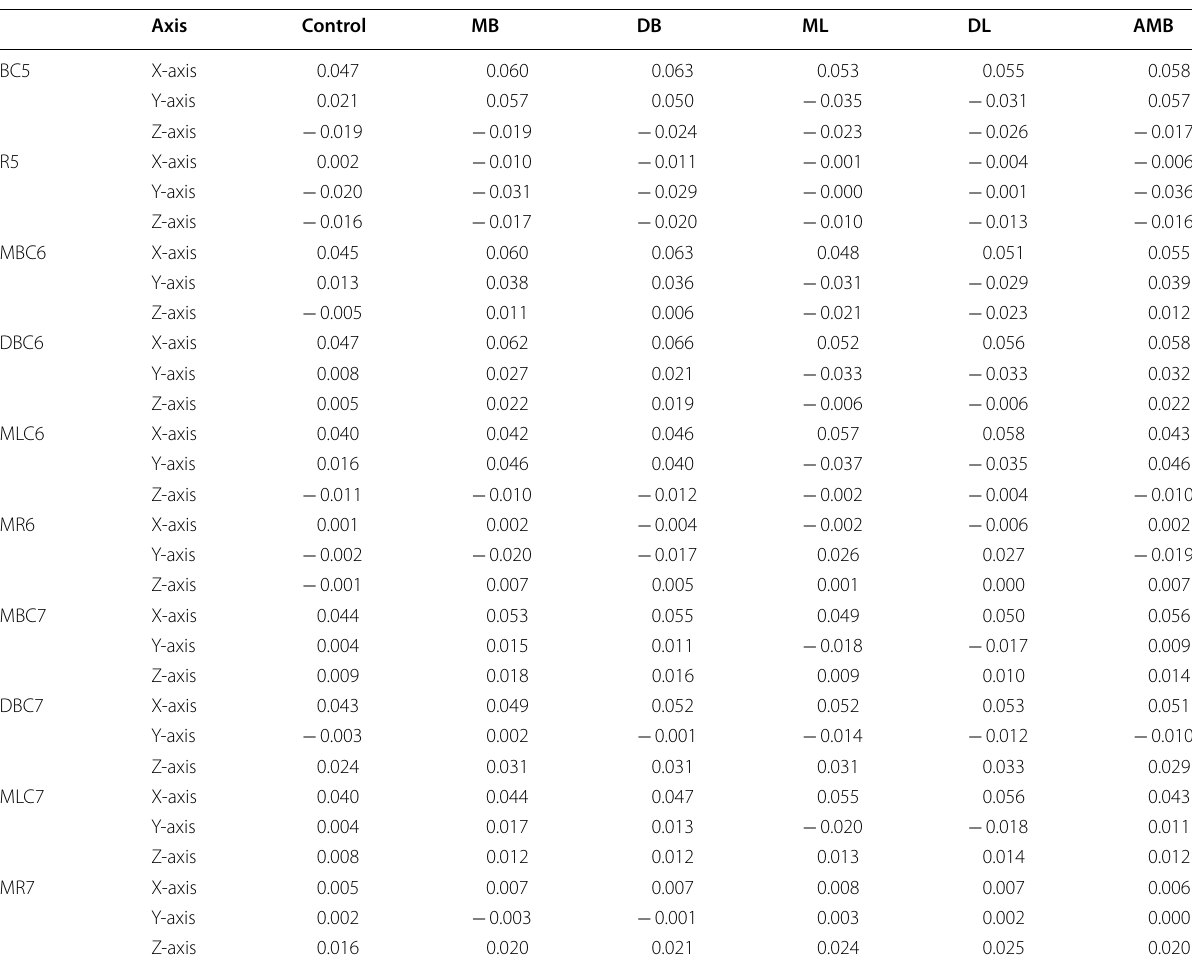
Table 5 Displacement of posterior teeth in the X-, Y- and Z-directions